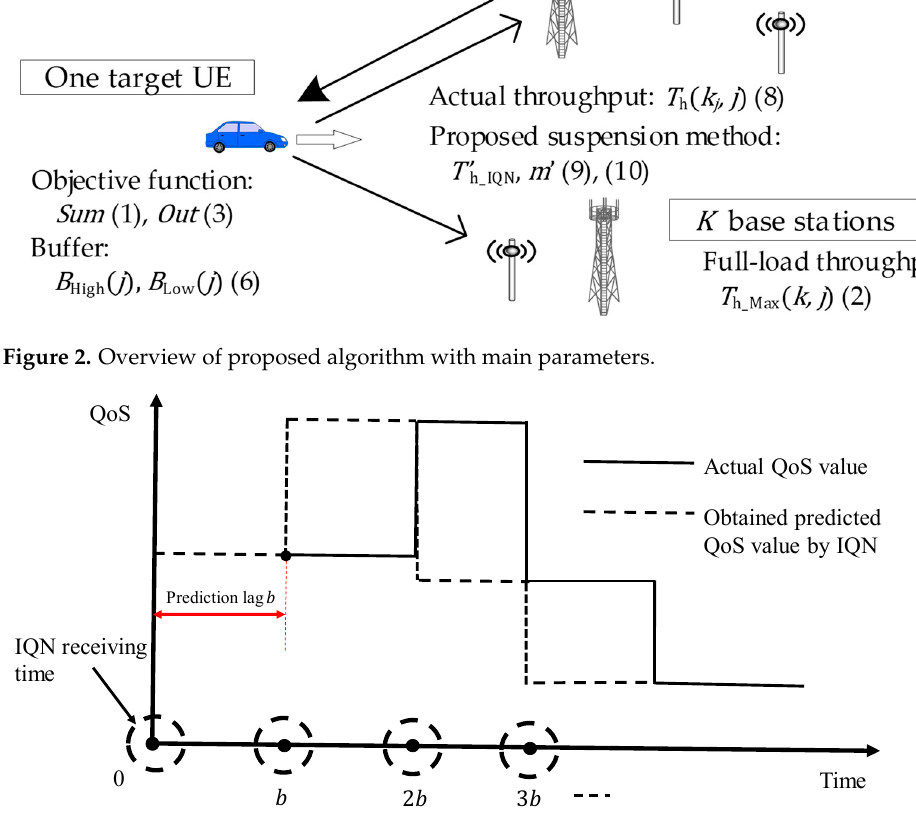
Figure 4. Transmission flowchart of vehicle. 3.4. High and Low Priority Data We assume that the vehicle generates two types of data: high and low priority data. The high priority data needs high immediacy and are used for applications utilizing in- formation such as location data or velocity information of the dynamic map. A typical configuration of the high priority data is 100 byte generated every 100 ms [40]. On the other hand, the low priority data does not need immediacy but high throughput. They consist of information such as entertainment information or movies. Consequently, we define the generation rate of high and low priority data as 𝜆 (cid:2892)(cid:2919)(cid:2917)(cid:2918) and 𝜆 (cid:2896)(cid:2925)(cid:2933) [Mbps], re- spectively, and buffer to be transmitted as 𝐵 (cid:2892)(cid:2919)(cid:2917)(cid:2918) (𝑗) and 𝐵 (cid:2896)(cid:2925)(cid:2933) (𝑗) [Mbit], respectively. In this study, we consider only these two data, and the following equations hold. 𝐵(𝑗) = 𝐵 (cid:2892)(cid:2919)(cid:2917)(cid:2918) (𝑗) + 𝐵 (cid:2896)(cid:2925)(cid:2933) (𝑗)